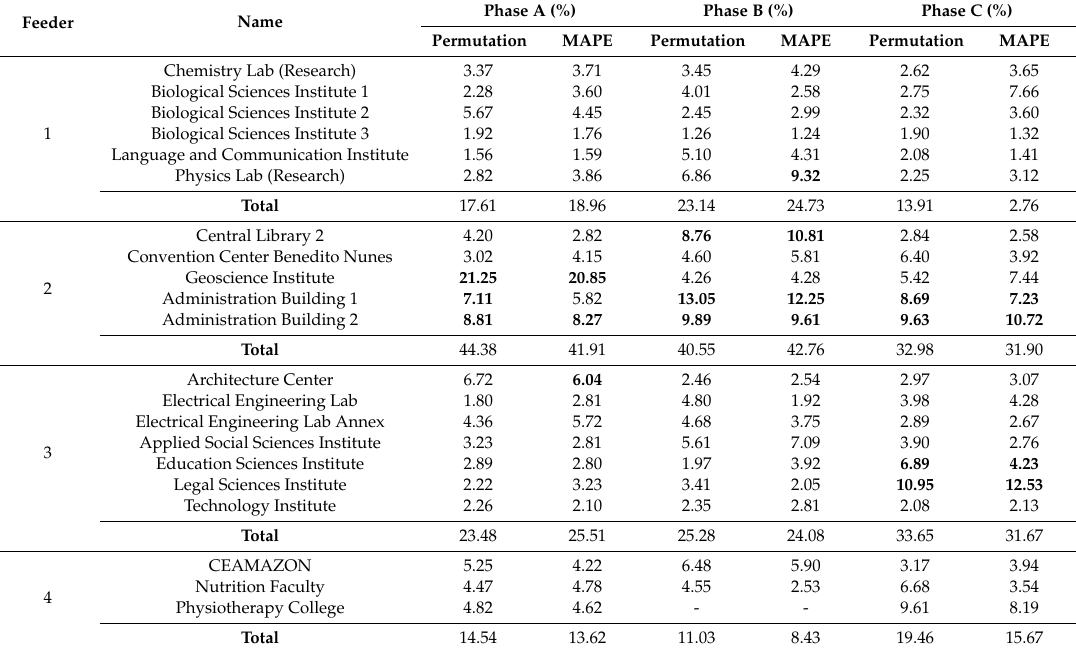
Table 8. Impact Factor percentage final results of the nonlinear loads at the CCP.